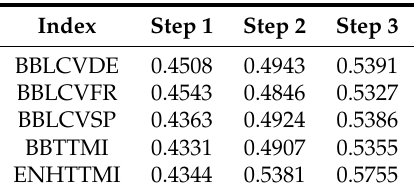
Table 11. Comparison of the ratios of absolute error for models for capital goods with an expanding window from 2008:01 to 2018:12.